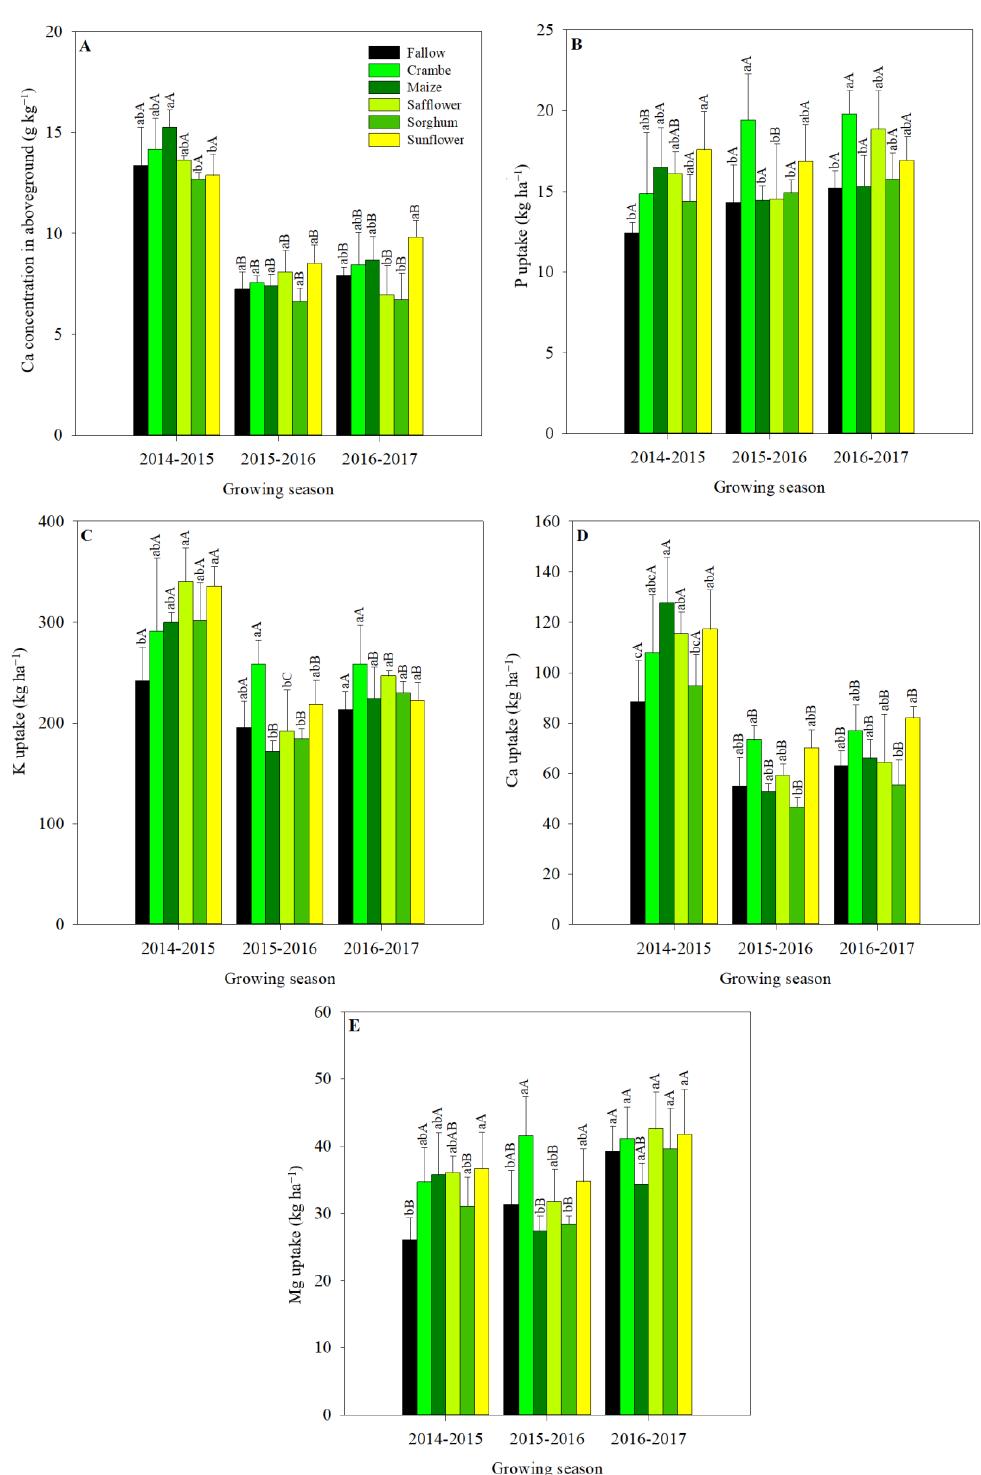
Figure 3. Growing season × previous crop interaction for Ca concentration in the aboveground ( A ) and P ( B ), K ( C ), Ca ( D ), and Mg ( E ) uptake of spring – summer soybean crop. Error bars represent standard errors of the mean. Lowercase letters compare previous crops within each growing season, whereas uppercase letters compare growing seasons within each previous crop at p < 0.05 according to Tukey’s test.